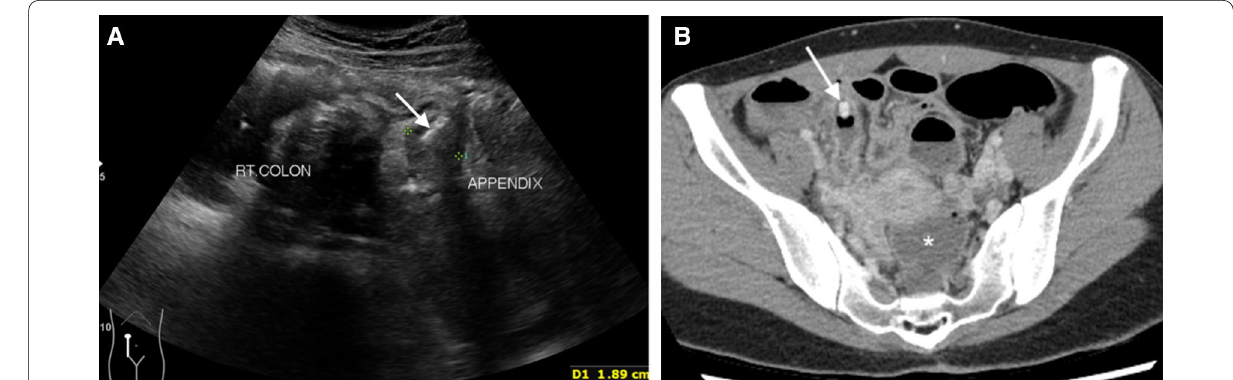
Fig. 7 Intraluminal appendicolith. An ultrasound image a of a 35-year-old woman presenting with right lower abdominal pain for 1 day, elevated white blood cell counts (23,790 cells/mm 3 ) and neutrophilia (93.3% neutrophils) shows a dilated appendix (arrows) with an intraluminal hyperechoic focus representing appendicolith. An obstructive appendicolith with acute appendicitis is confirmed on subsequent CT b that also reveals fluid in the cul-de-sac (asterisk) and peritoneal enhancement. Perforated appendicitis with turbid intraperitoneal fluid was confirmed at surgery